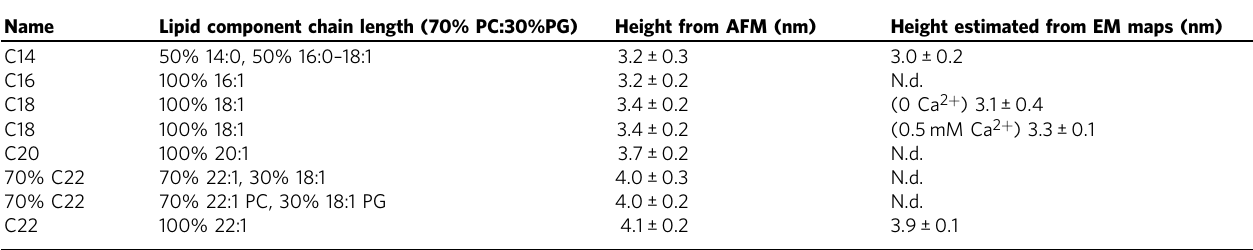
Heights were estimated using AFM tomography, reported values indicate the peak FWHH±of the value distribution (see Supplementary Fig. 4A, B and Methods). Membrane height from cryoEM was determined from C1 unsharpened EM maps using the difference in z coordinate for the inner and outer lea fl et at (x,y) far from the protein. Reported values are the average±S.Dev of 3 different points. N.d. indicates compositions for which no cryoEM data was